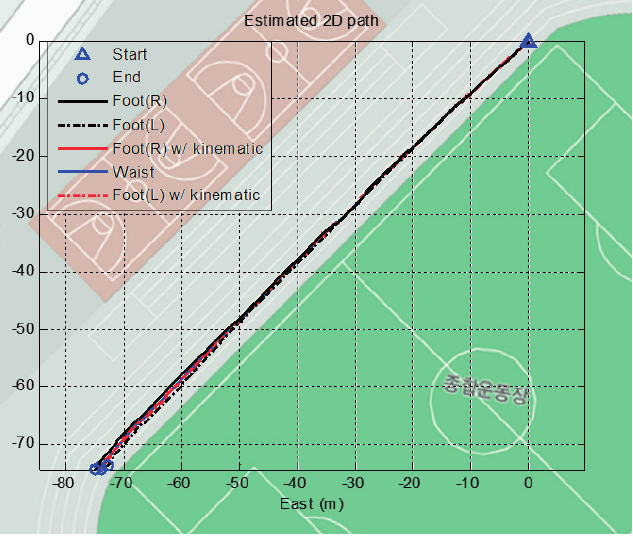
Figure 16. Result of straight line trajectories test (total distance: 106.06